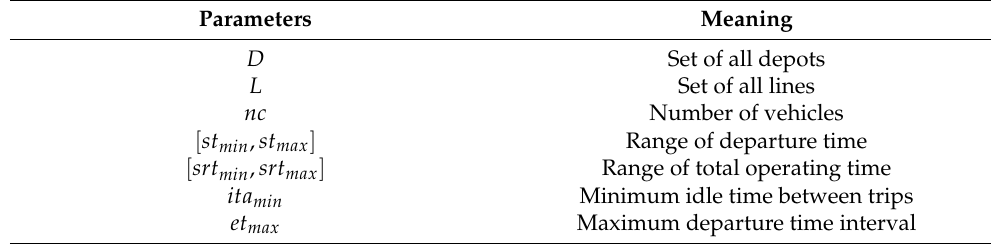
Table 1. Operational